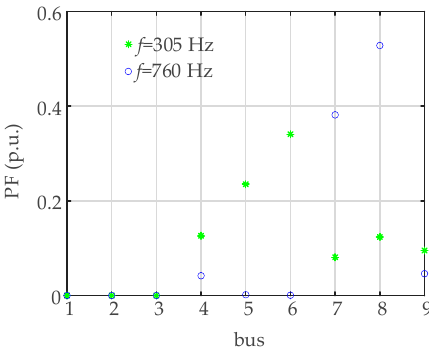
Figure 8. PFs corresponding to resonance frequencies f = 305 Hz and f = 760 Hz.